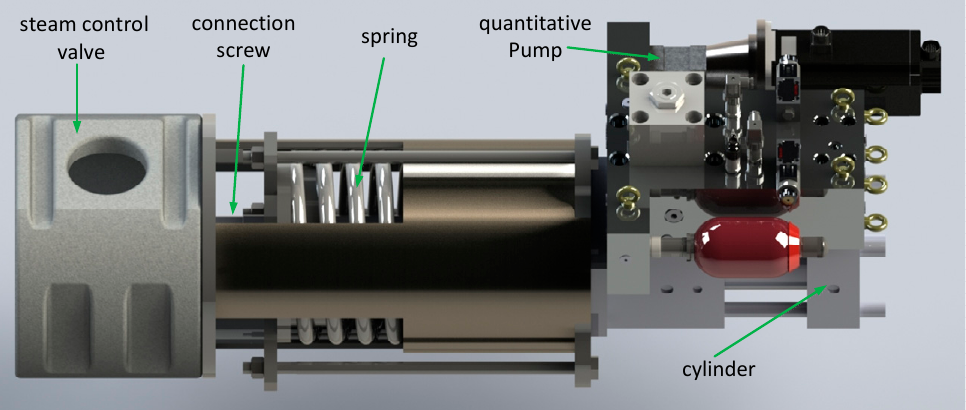
Figure 1. Working principle diagram of a SM.